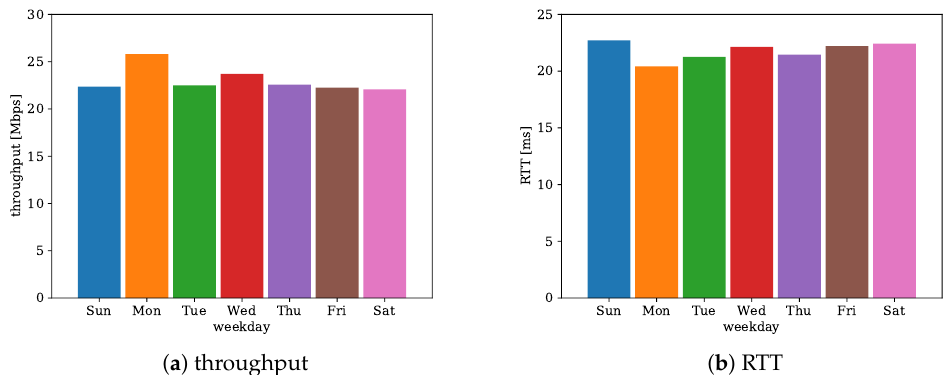
Figure 5. Weekly pattern of throughput and RTT shown as median